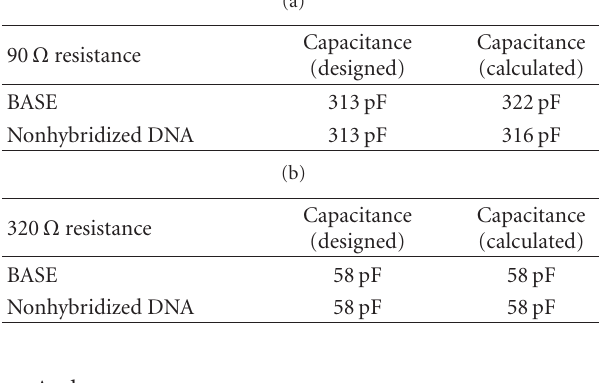
Table 3: (a and b) The capacitance calculated from the circuit models (LPF and CF) for nonhybridizing DNA sensors.